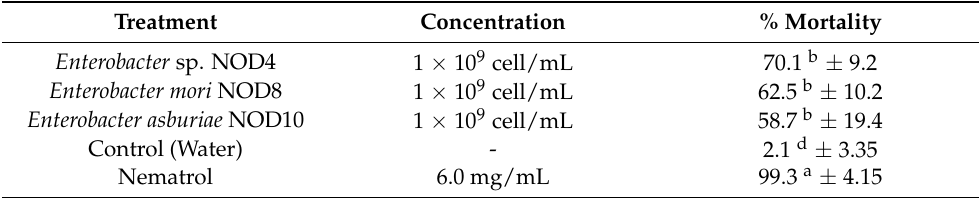
Table 3. In vitro evaluation of Enterobacter strains against Nacobbus aberrans (J2). Treatment Concentration